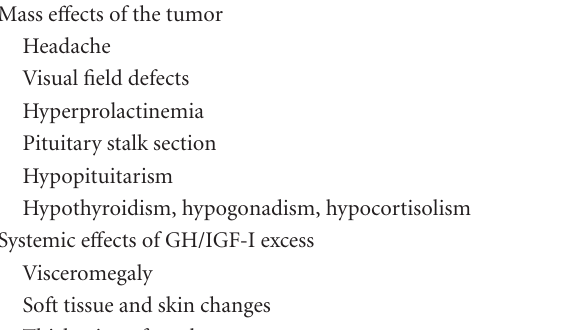
Table 1: Clinical manifestations of